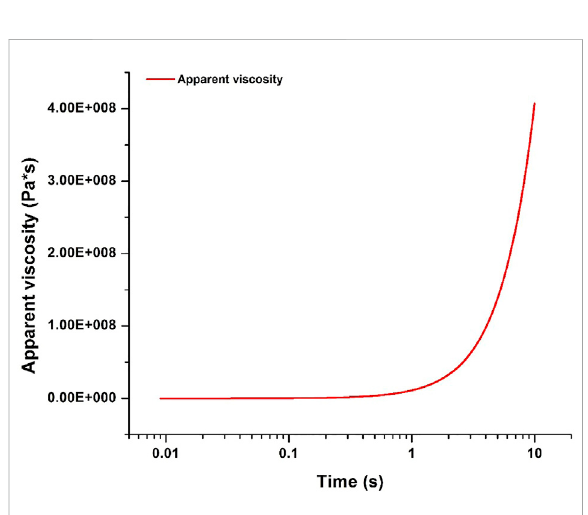
the corresponding theoretical values (shallow blue dash line and green dots, respectively).